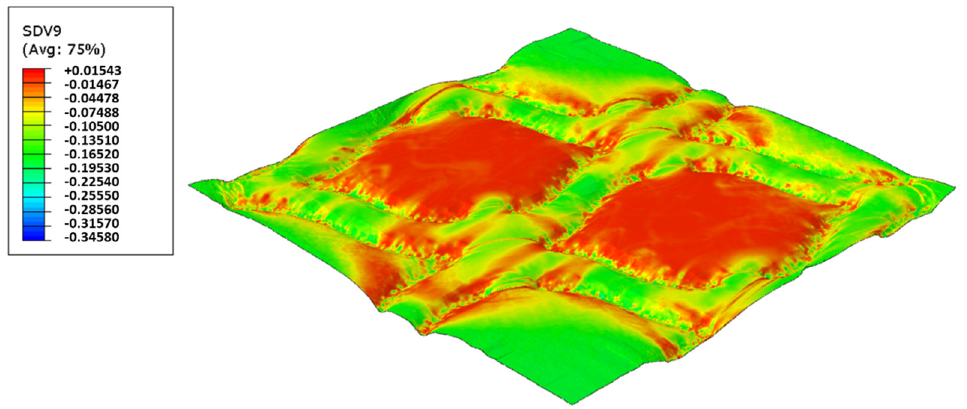
Figure 28. Deco die 48_60 Sh-A (NR BG/SBR PR), Plastic field.